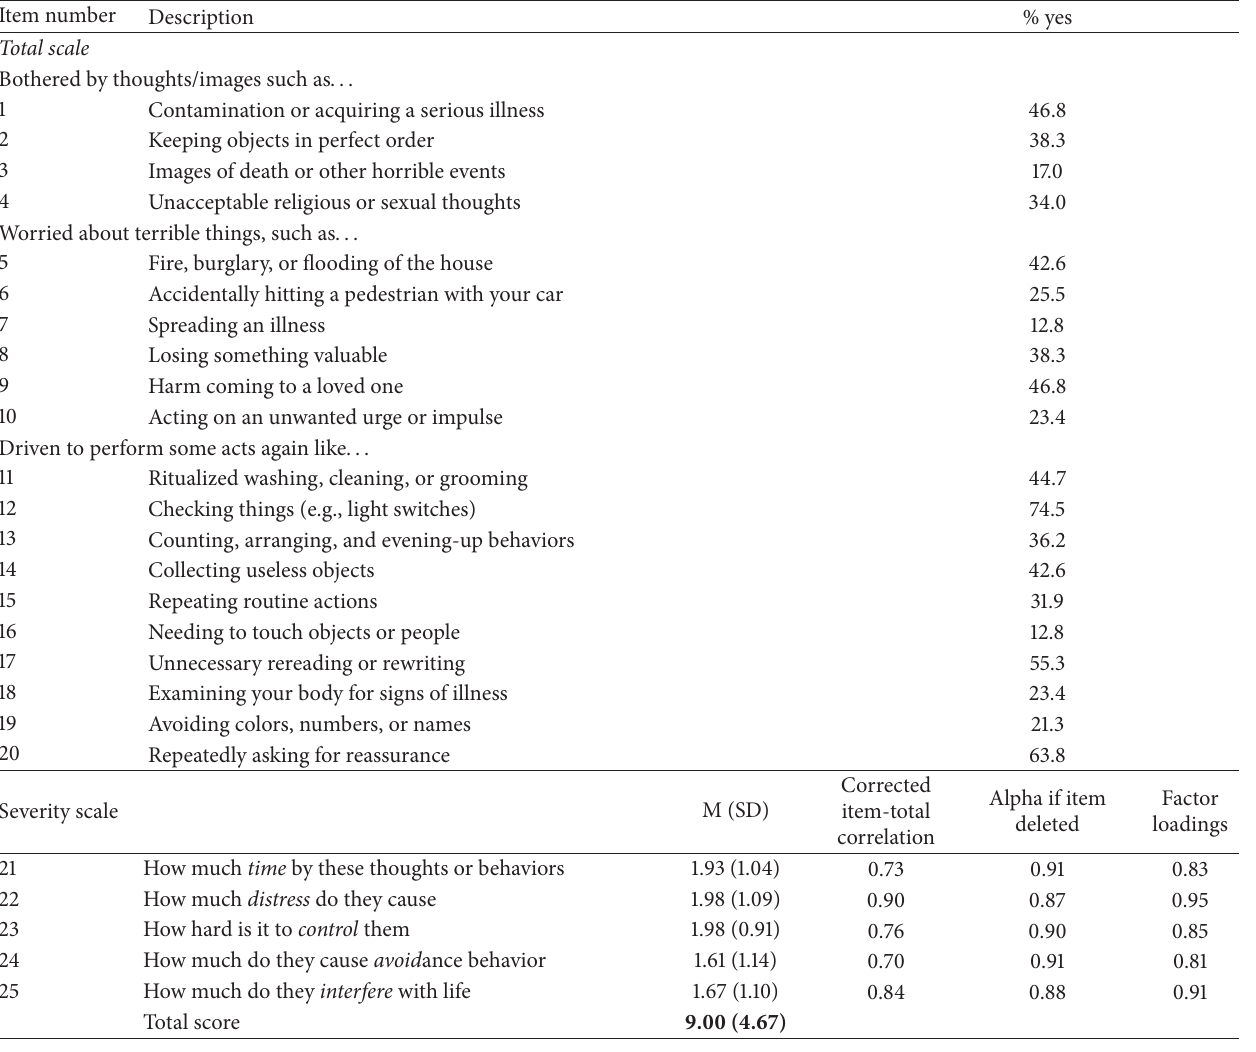
Table 1: The frequencies of the Symptom Checklist items and the means; standard deviations; item-total correlations; and factor loadings of the severity items of the